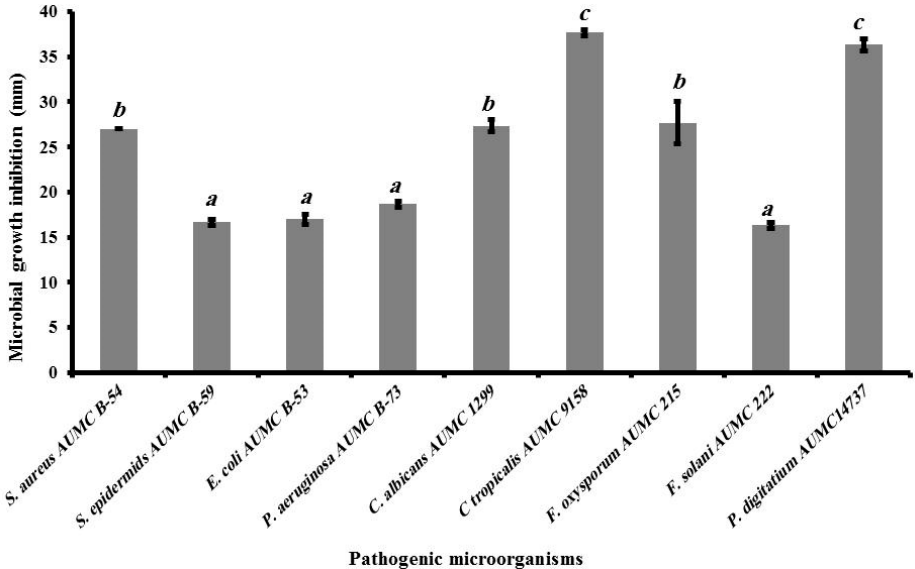
Figure 12. The antimicrobial activities of extract of infected tomato plant as microbial growth inhibition zone (mm) against Gram negative bacteria ( Escherichia coli AUMC B-53 and Pseudomonus aeruginosa AUMC B-73), Gram positive bacteria ( Staphylococcus aureus AUMC B-54 and Staphylococcus epidermids AUMC B-59), yeasts ( Candida albicans AUMC 1299 and Candida tropicalis AUMC 9158) and filamentous fungi ( Fusarium oxysporum AUMC 215, Fusarium solani AUMC 222, Penicillium digitatium AUMC14737), data are means ± SD ( n = 3), with statistically significant differences ( p < 0.05).